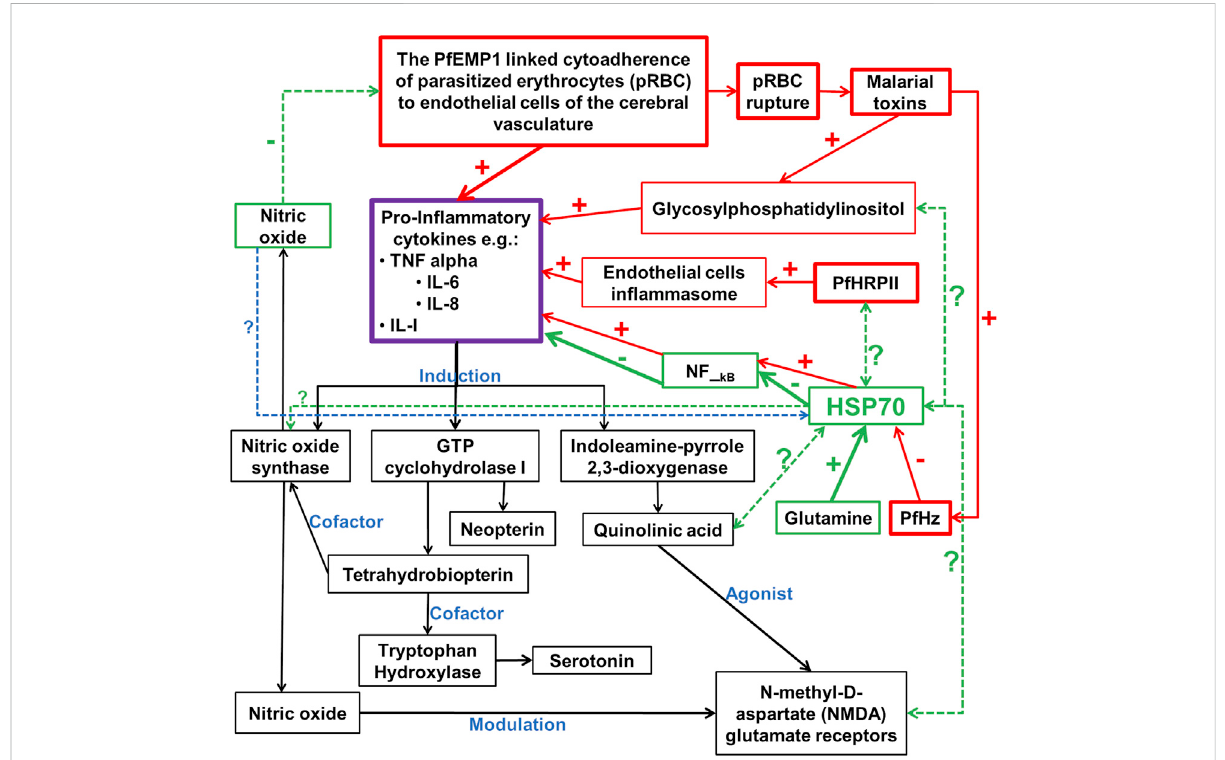
FIGURE 1 Potential chaperones linked neurotransmitter pathways of the in fl ammation pathophysiologic mechanism of cerebral malaria. PfEMP1 is P. falciparum erythrocyte membrane protein 1; PfHz is hemozoin; PfHRPII is P. falciparum histidine-rich protein II; In red boxes are the pro- in fl ammatorycytokinesinducers;In green boxes arethe potentially major playersintheinhibition ofpro-in fl ammatorycytokines; In black boxes are downstream biochemical cascade potentially linked to the neurological syndrome in cerebral malaria; - and + signs indicate inhibition and induction respectively; ? With dotted double or single-faced arrows are potential functional relationships that are yet to be or partially investigated respectively; - and + signs with arrows are reported functional relationships with HSPA1A, but not for plasmodial Hsp70